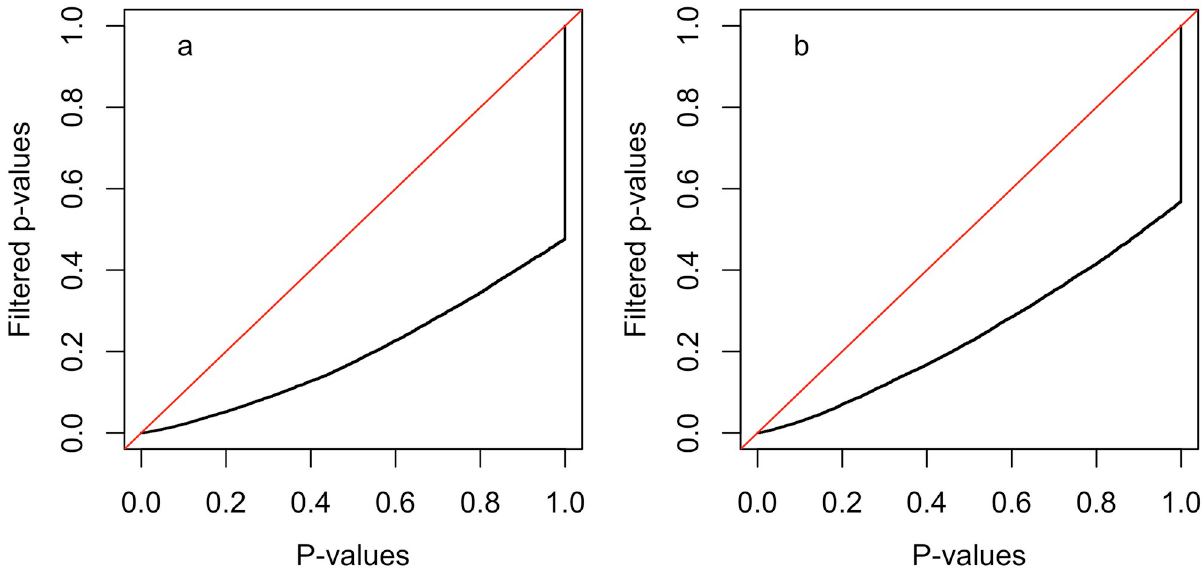
Fig 5. Quantile-quantile plots illustrating the impact of tissue-specific gene filtering on gene set testing of MSigDB Hallmark pathways using cancer/normal relative expression ( r i , j ). Each plot contrasts the distribution of p-values (the black line) from tests for all 50 Hallmark pathways for each of the 21 cancer/normal pairs (total of 1050 tests) using all genes or genes filtered according to tissue-specificity. The red line has a slope of 1.0 and captures the distribution that would be expected if filtered and un-filtered p-values had the same distribution. In both panels, the x-axis reflects the p- value distribution when all genes are included and the y-axis reflects the p-value distribution when genes are filtered according to normal tissue- specificity ( n � ). Panel a) contains the results from tests for enrichment of large r statistics among the gene set members (i.e., are gene set members more likely to be up-regulated in cancer vs. the normal tissue?) and gene filtering removed the 20% of genes with the largest tissue-specificity values (i.e., kept genes that are less tissue-specific). Panel b) contains the results from tests for enrichment of small r i , j statistics among the gene set members (i.e., are gene set members more likely to be down-regulated in the cancer vs. the normal tissue?) and gene filtering removed the 20% of genes with the smallest tissue-specificity values (i.e., kept genes that are more tissue-specific). For both panels, the p-values for gene sets whose direction of enrichment is opposite the target direction were set to 1.0, which causes the vertical portion of the black line. As illustrated in the Q-Q plots, gene filtering in both cases improved gene set testing statistical